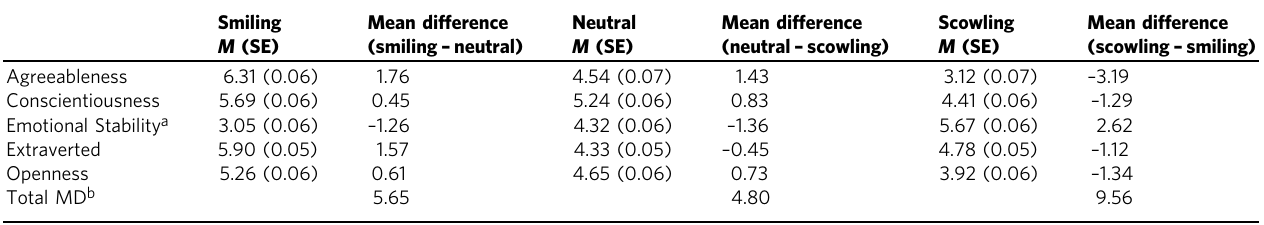
Table 5 Facial expressions and the Big-Five personality traits ( M , SE, Mean